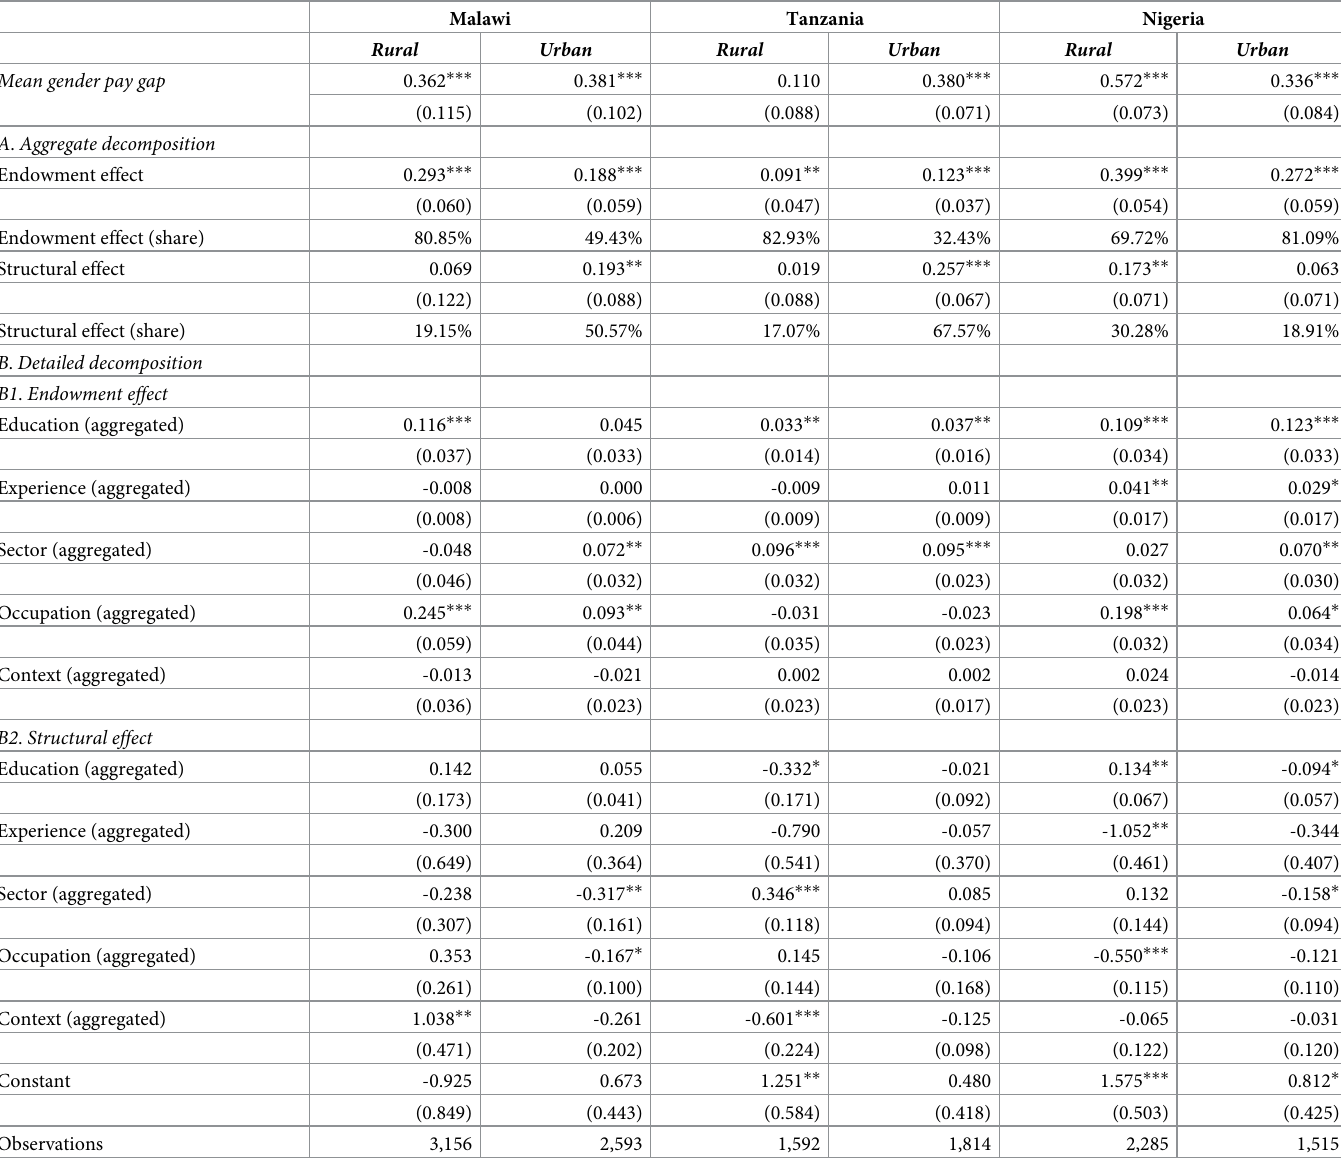
Table 4. Kitagawa-Oaxaca-Blinder decomposition of gender pay gap for non-farm employed people aged 25–55 in Malawi, Tanzania and